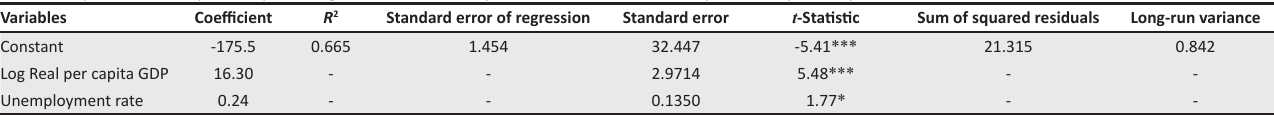
TABLE 2: Dynamic ordinary least squares regression results – Dependent variable: Total entrepreneurship activity. Variables Coefficient R 2